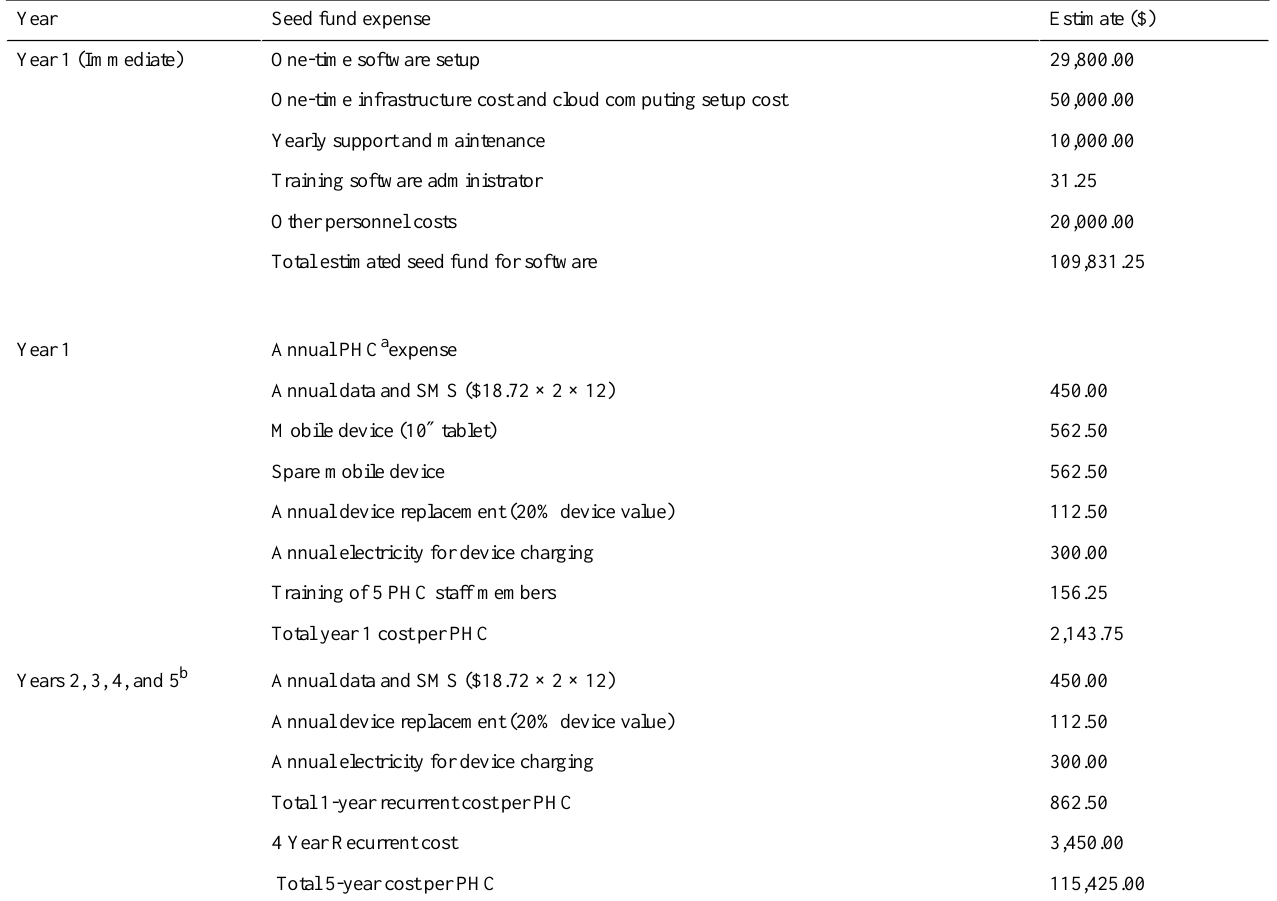
Table 6. Software setup and operation